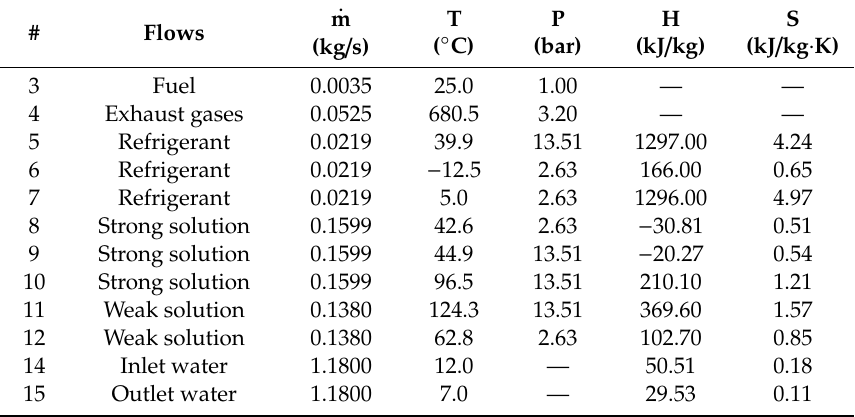
Table 3. Thermodynamic assessment